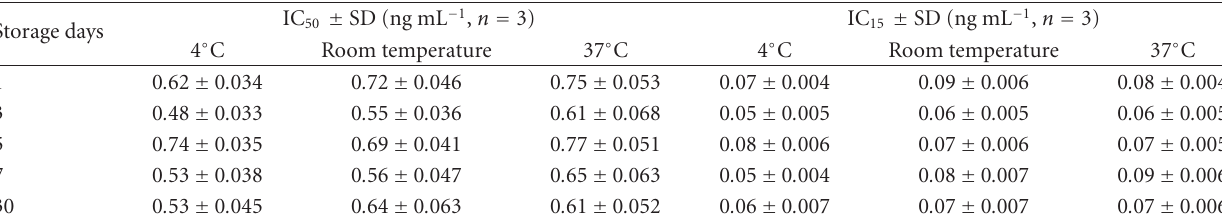
Table 1: Stability of the RAC-antibody.